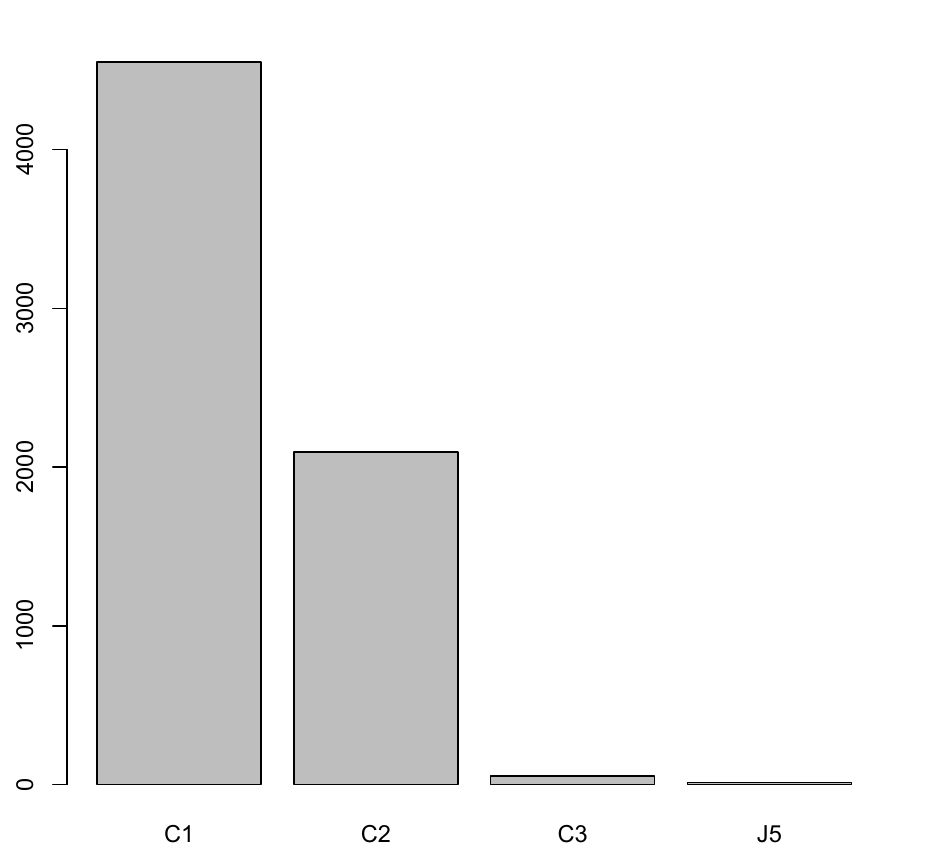
FIGURE 2: Representativeness of the different EUNIS habitats in the data set. C1 Surface standing waters; C2 Surface running waters; C3 Littoral zone of inland surface waterbodies; J5 Highly artificial man-made waters and associated